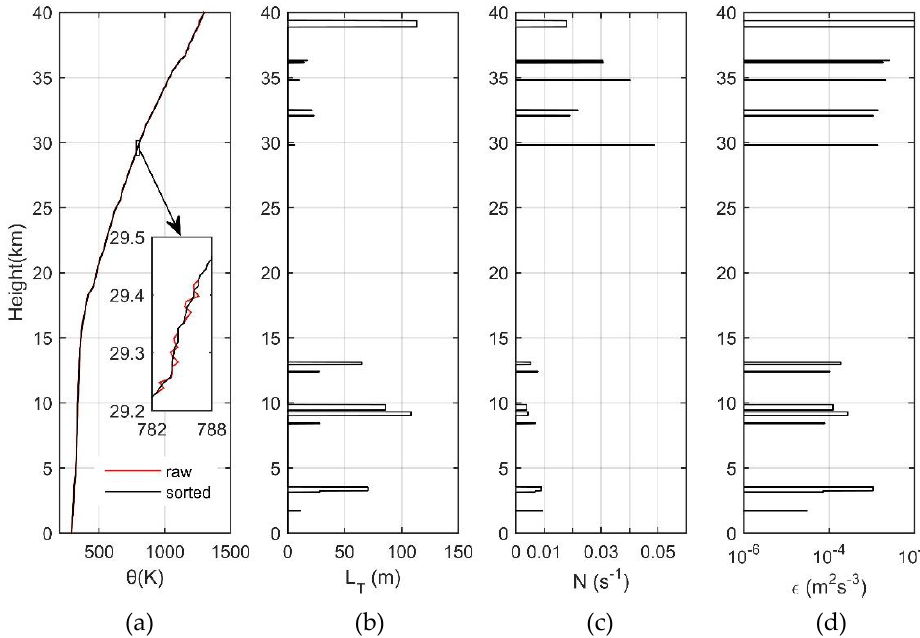
Figure 4. ( a ) Potential temperature; ( b ) Thorpe scale; ( c ) buoyancy frequency; and ( d ) turbulent energy dissipation rate.